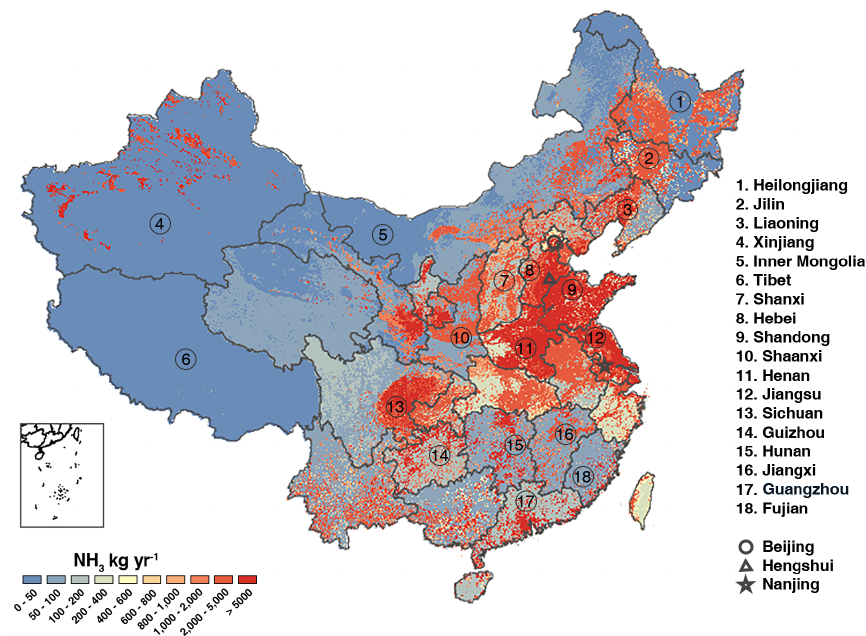
Figure 2. Spatial distribution of ammonia emissions with a spatial resolution of 1km × 1km grid (kgyr − 1